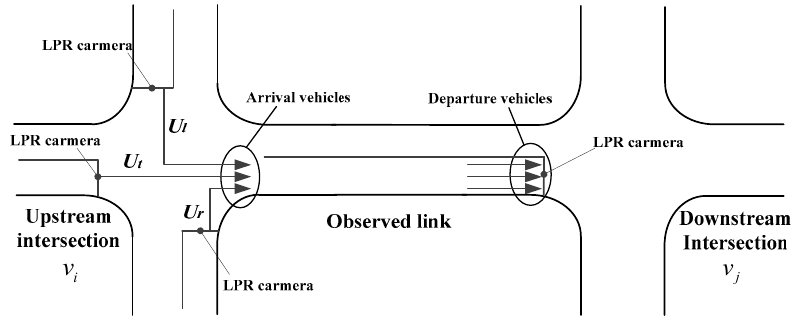
Figure 1. Illustration of arrival vehicles from the upstream intersection.